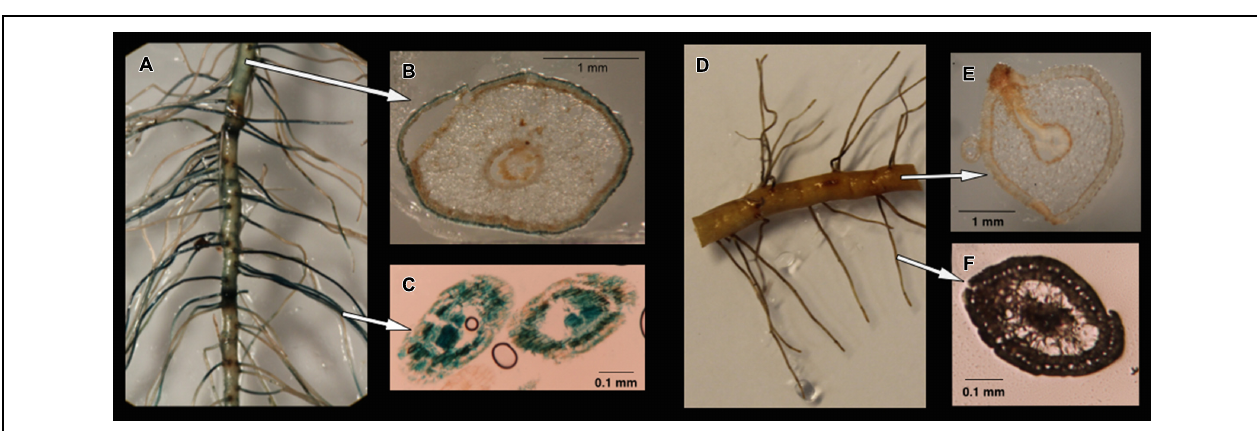
FIGURE 3 | (A) Colonization of Gal22 transformant, carring a nifH::gusA fusion, on Rhizophora mangle roots after the treatment − N/ − C. Cells are localized by the blue color formation from gusA activity. (B) Root surface bacterial